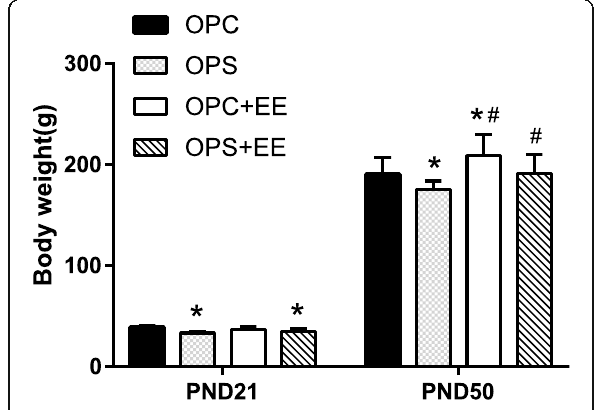
Fig. 4 The comparison among OPC, OPS, OPC&EE and OPS&EE in body weight. Differences in body weight were detected among OPC, OPS, OPC&EE, and OPS&EE. The body weight is the lowest in OPS group, the highest in the OPC&EE group; meanwhile, the body weight of OPS&EE is higher than OPS. Data were respectively analyzed using one-way ANOVA, followed by LSD-t test to make comparison at the two different groups. Number of animals in each offspring group = 16 (50% male, 50% female) * P < 0.05 vs. OPC. # P < 0.05 vs.